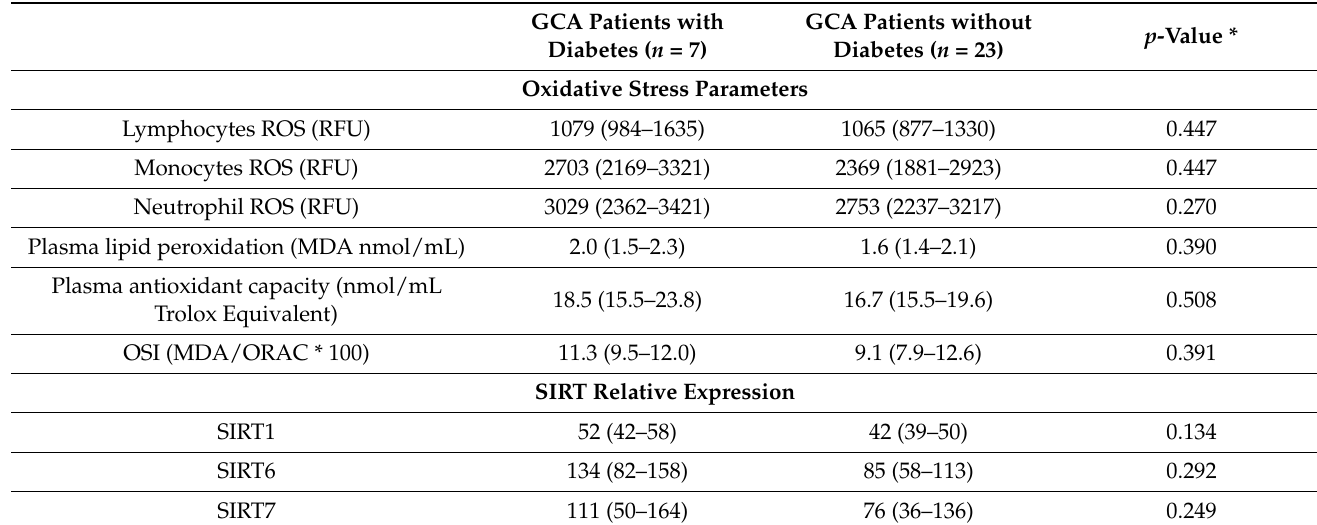
Table 2. Blood oxidative stress parameters and sirtuin expression in the GCA patients with and without